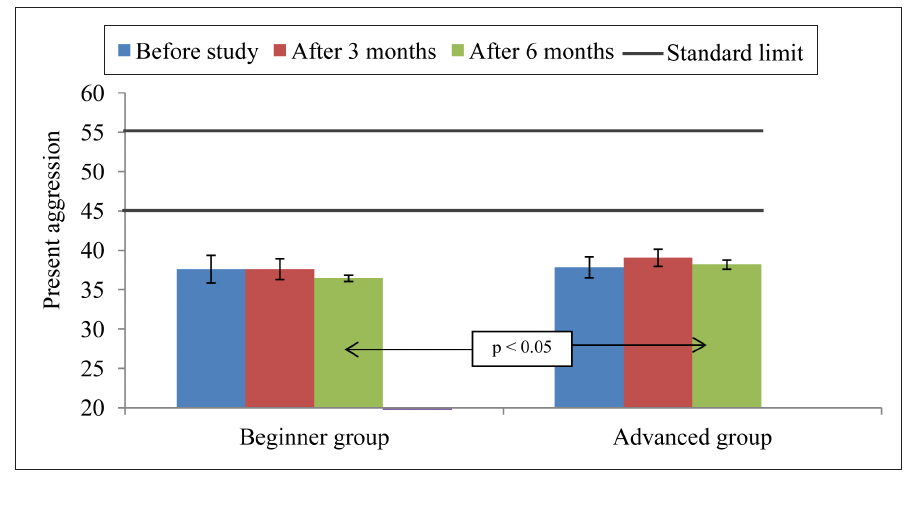
Figure 5. Present emotional lability in the beginner